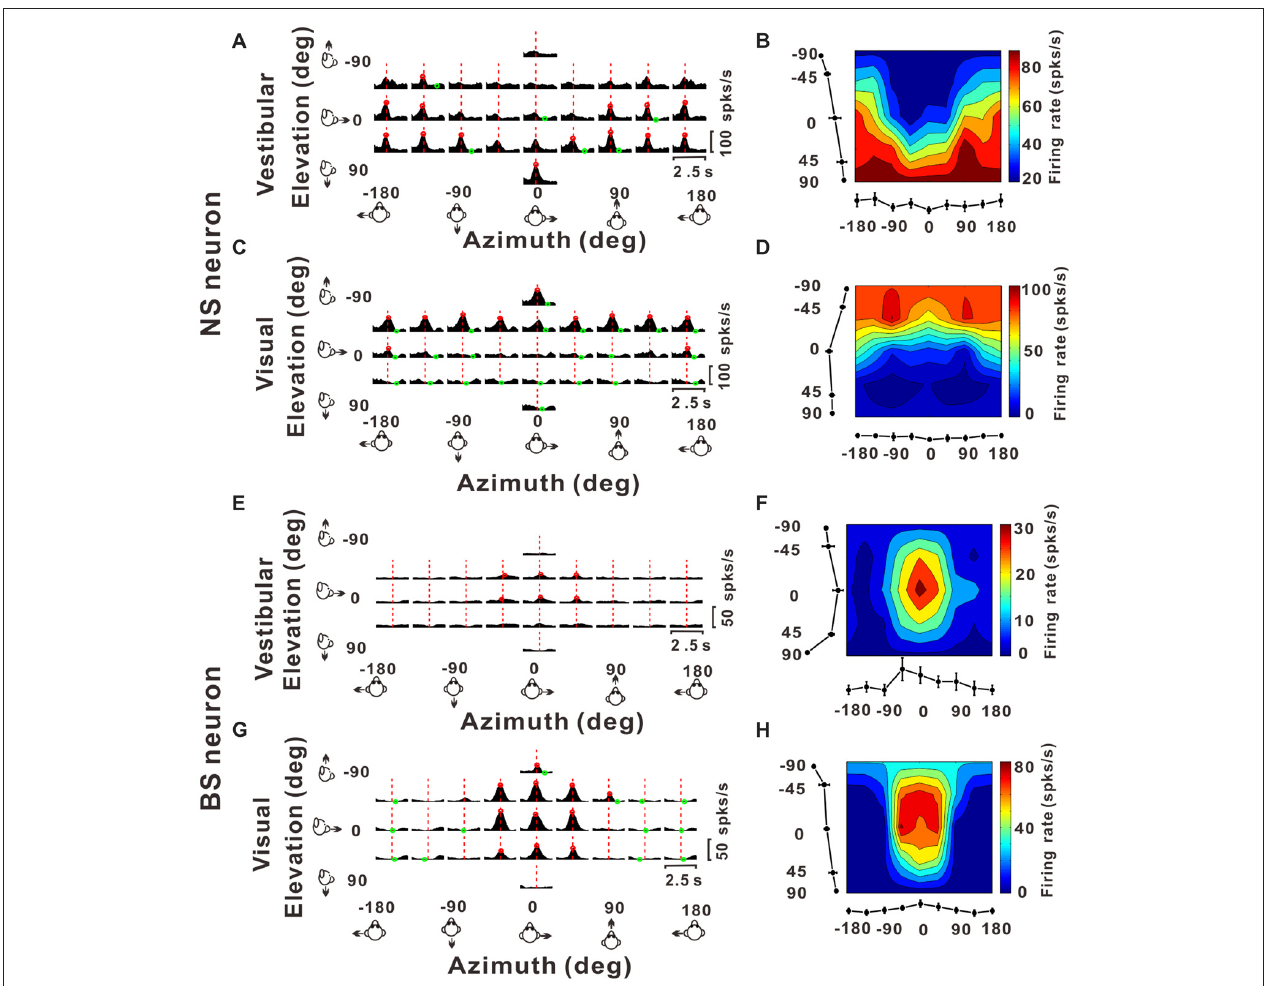
FIGURE 3 | Example responses from a NS neuron and a BS neuron. (A,C,E,G) Response peristimulus time histograms (PSTHs) for an example NS neuron ( A for vestibular stimuli and C for visual stimuli) and an example BS neuron ( E for vestibular stimuli and G for visual stimuli). The averaged PSTHs for all 26 directions of vestibular or visual translation arranged according to stimulus direction in spherical coordinates. Vertical dashed red lines indicate the peak time of the neuron. PSTHs were computed with sequential 25 ms bins and then smoothed with a 400 ms sliding window (see “Materials and Methods” section). (B,D,F,H) Color contour maps of the neurons at the peak time. The peak time was taken from the preferred direction. Tuning curves along the bottom and left sides of each color contour maps show the 3D tuning at the peak time indicated by the red dashed lines in panels (A,C,E,G) . Noted that because azimuth 180 ◦ (away from azimuth 0 ◦ anticlockwise) and azimuth − 180 ◦ (away from azimuth 0 ◦ clockwise) are overlapped on the horizontal plane, so in panels (A,C,E,G) , the left-most three panels were just copied from the right-most three panels for symmetry and actually there were only 26 directions out of the 29